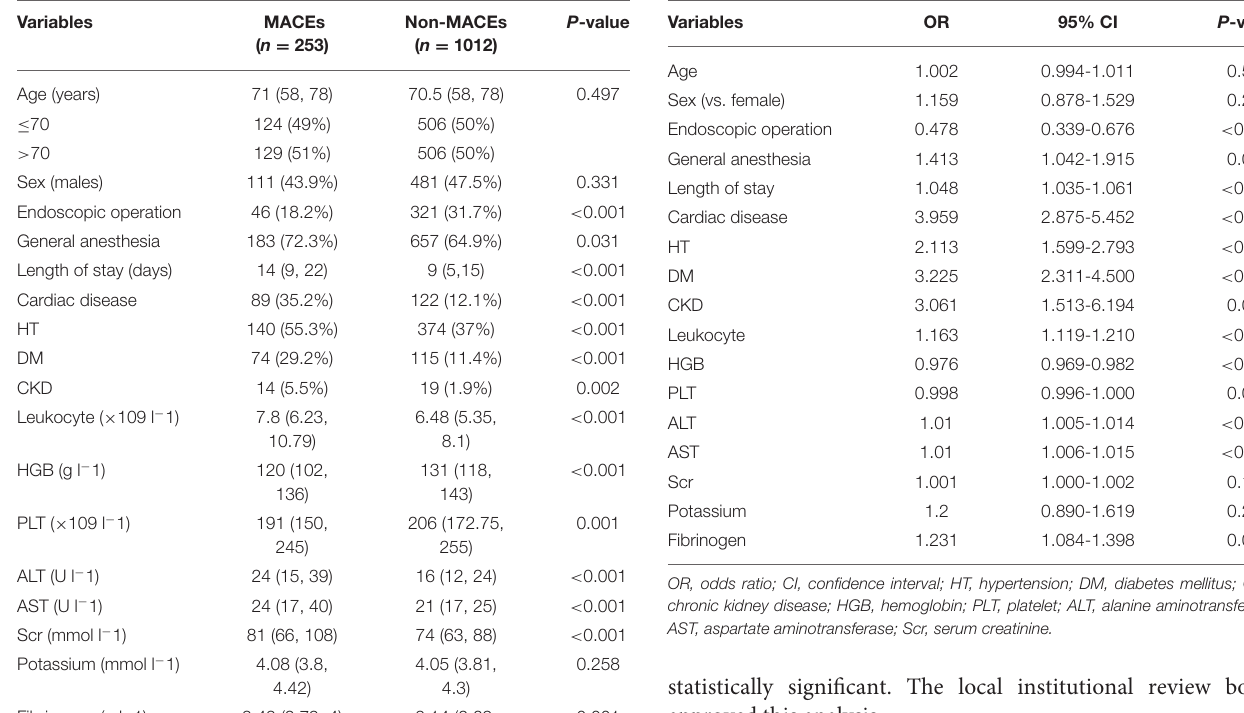
TABLE 3 | Results of univariate logistic regression